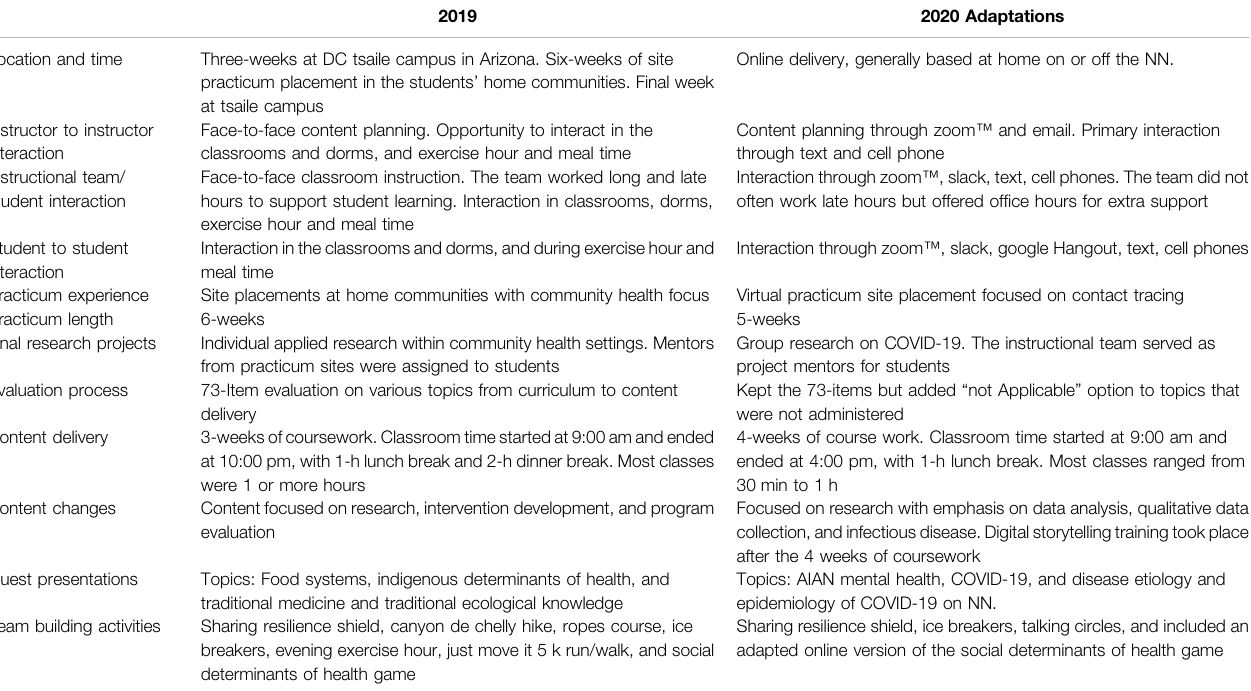
TABLE 2 | Summer Research Enhancement Program adaptions for